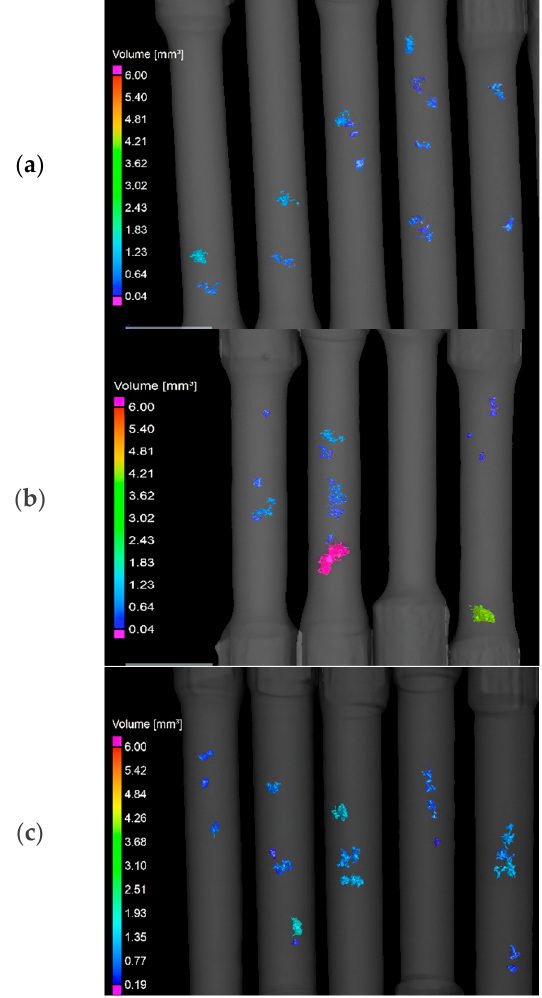
Figure 7. CT Reconstruction of Defect Volumes of AlMgCu Alloys ( a ) A3.1 ( b ) A3.2 ( c ) A3.3.